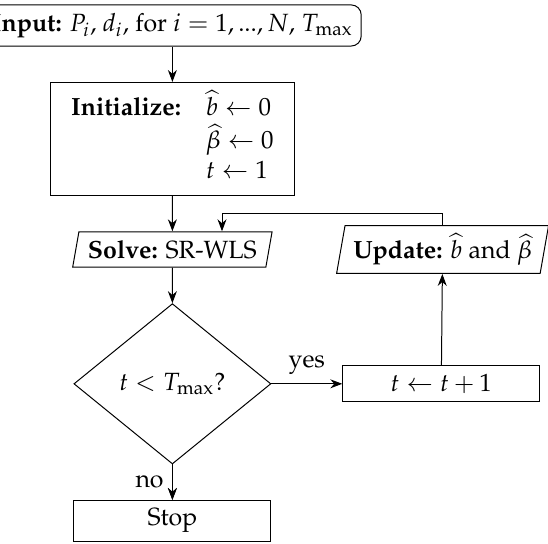
Figure 1. Flow chart diagram of the SR-WLS algorithm in